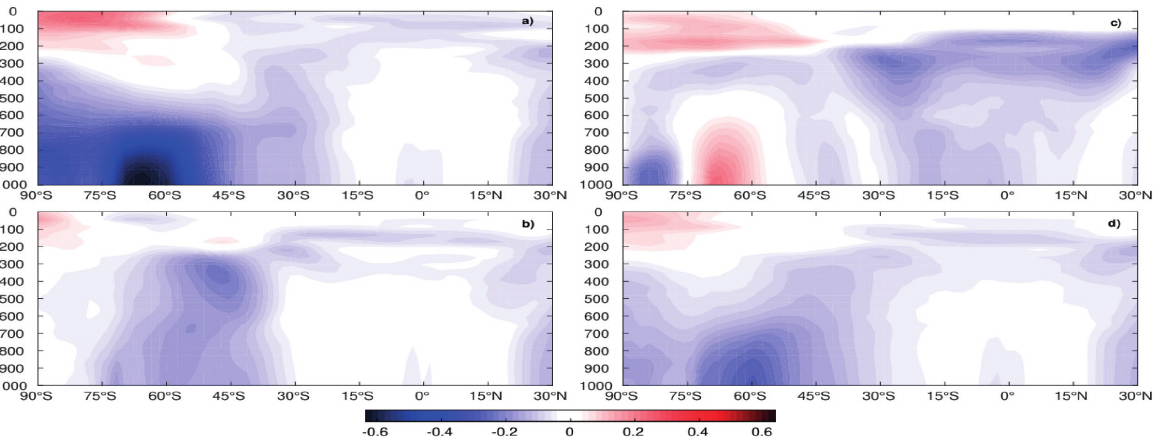
Figure 2. Differences between the layermax-layerctl experiments for the zonal mean (from 90°S to 30°N) air temperature profile (°C) for the Atlantic sector (from 65°W to 15°E) during the periods: a) July 2020–June 2024;